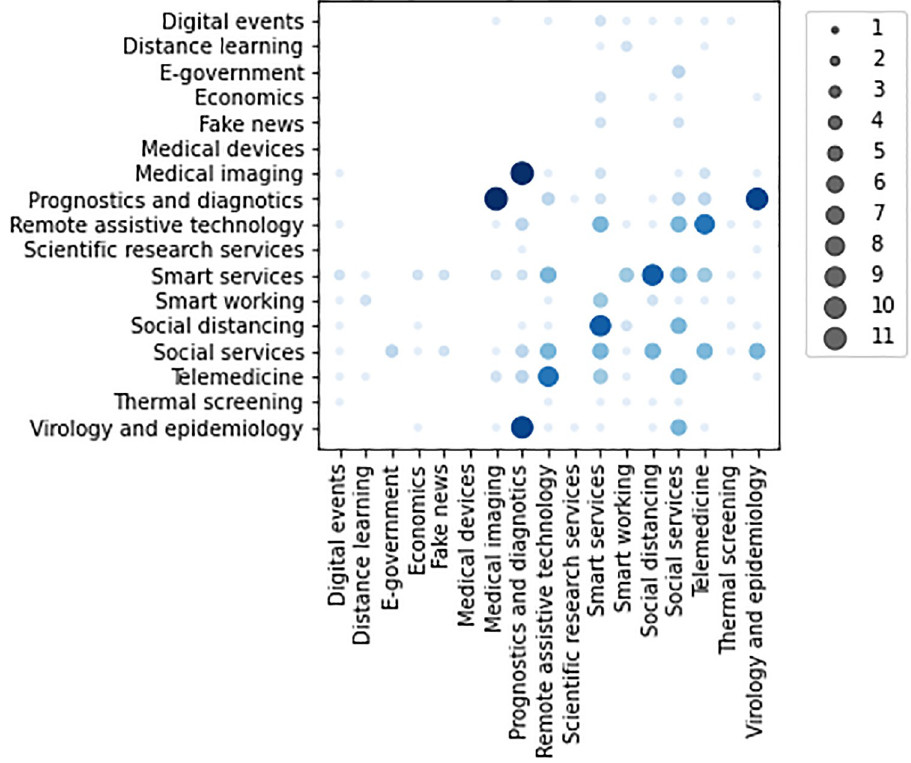
Fig 11. Co-occurrence of application contexts indicated as high relevant for the surveyed activities.